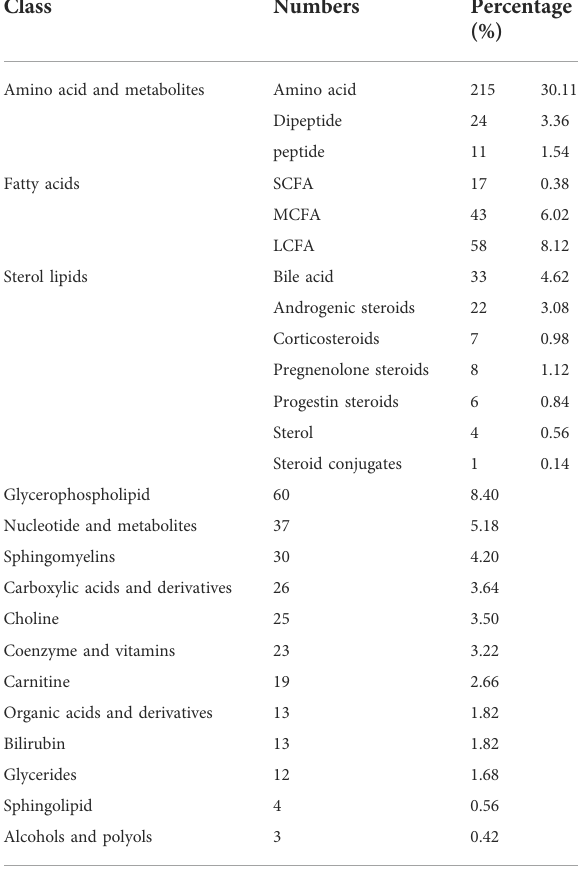
TABLE 2 Classi fi cation of